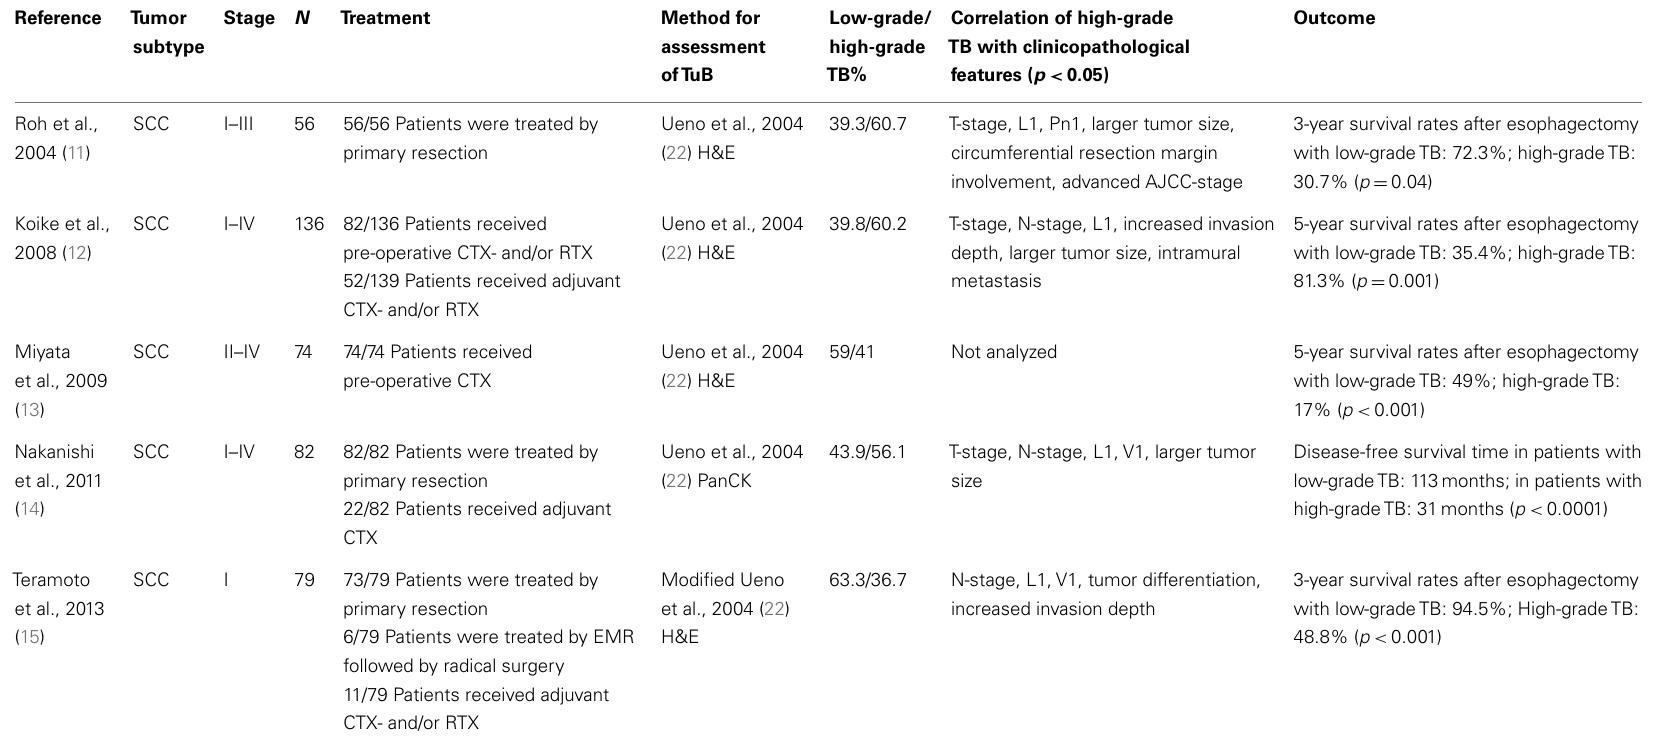
Table 2 | Studies on tumor budding as a histomorphological prognostic factor in squamous cell carcinoma of the esophagus .